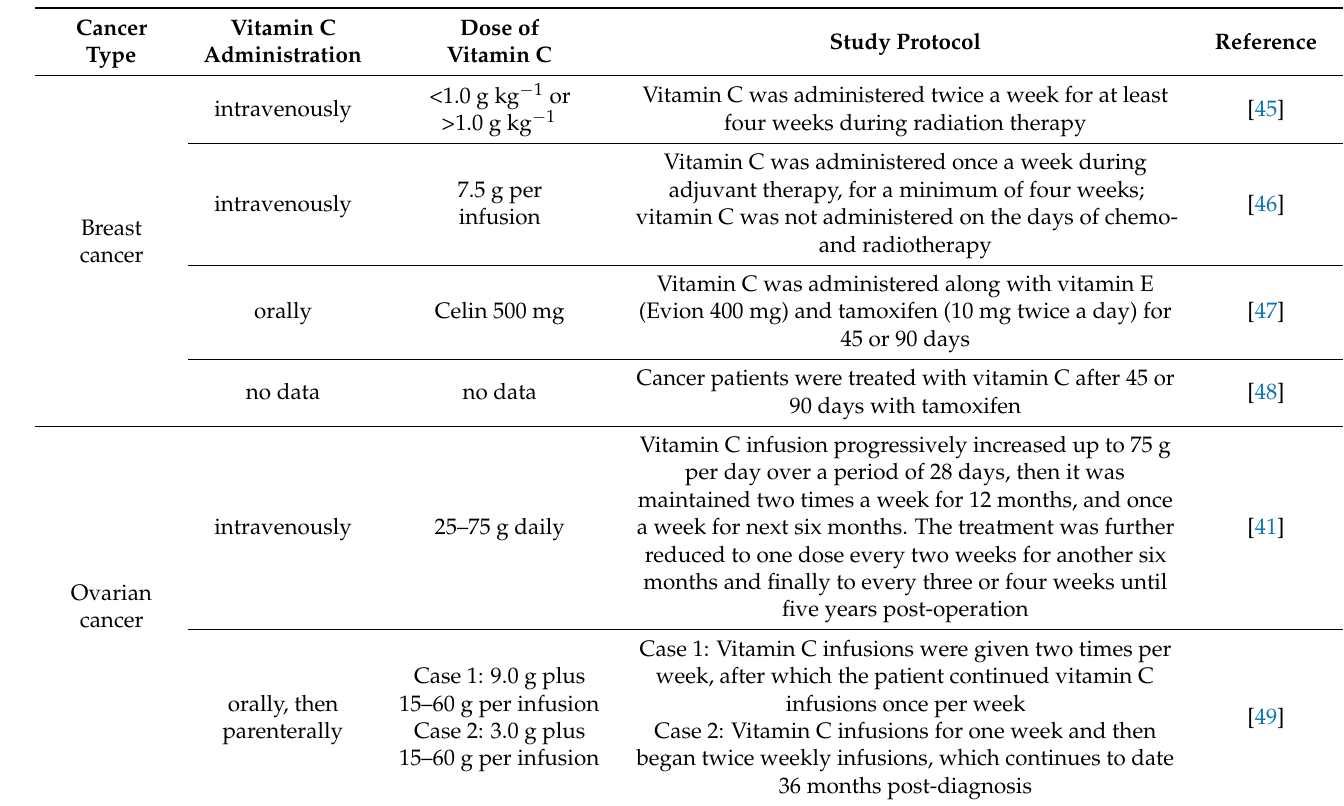
Table 2. Observational studies on the use of vitamin C with chemo- or radiotherapy in selected malignant neoplasms in